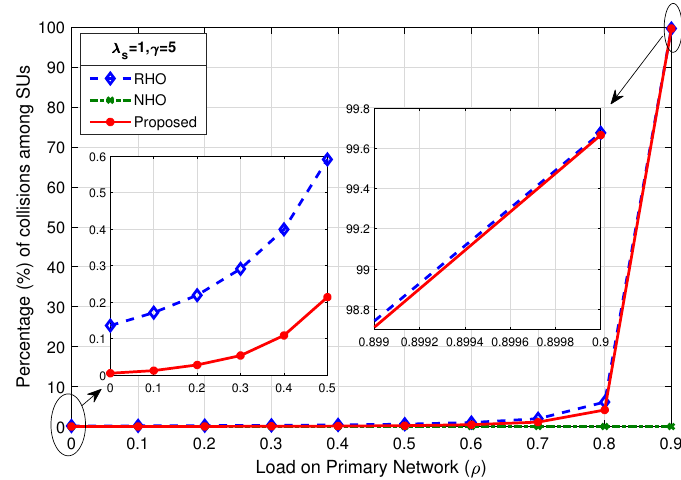
Figure 6. Comparison of percentage of collisions among SUs for λ s = 1, γ = 5.